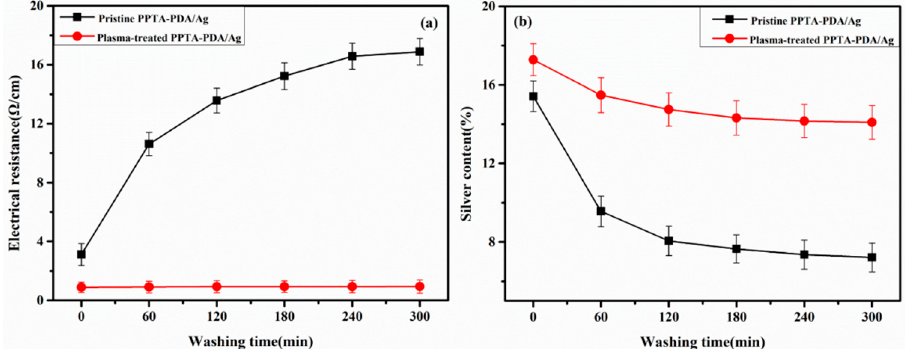
Figure 8. The variation of electrical resistance ( a ) and silver content ( b ) of pristine PPTA-PDA/Ag fibers and plasma-treated PPTA-PDA/Ag fibers with washing time. The AgNO 3 concentration was 20 g/L.